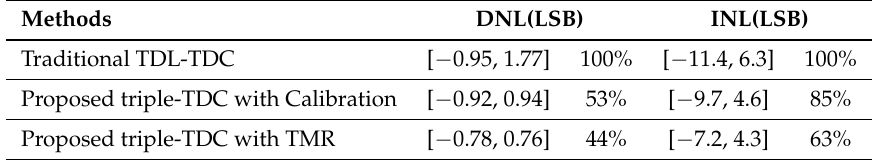
Figure 8. Measured RMS values for the proposed triple-TDC. Table 3. INL and DNL for the proposed triple-TDC with TMR in single-mode.